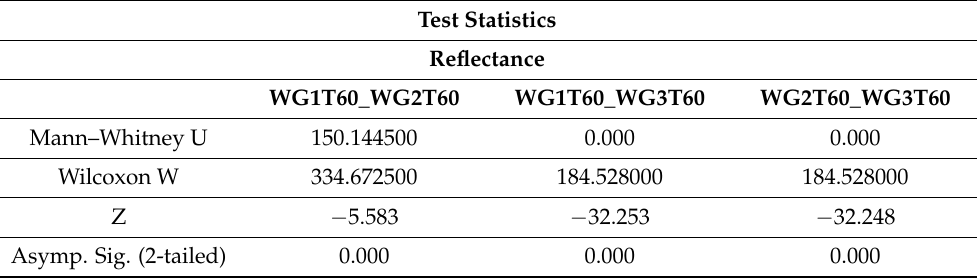
Table A14. Test statistics table of Mann–Whitney test for specular solar reflectance, according to the holding time of 60